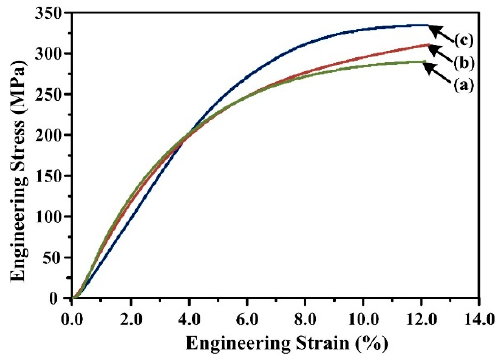
Figure 6. Engineering stress ‐ stain curves of Al ‐ 20Mg 2 Si alloys: with: ( a ) 0; ( b ) 0.2; and ( c ) 0.5 wt.% Li ‐ Sb addition. Table 1. Mechanical properties of Al ‐ 20Mg 2 Si alloys modified with 0, 0.2 and 0.5 wt.% Li ‐ Sb (the